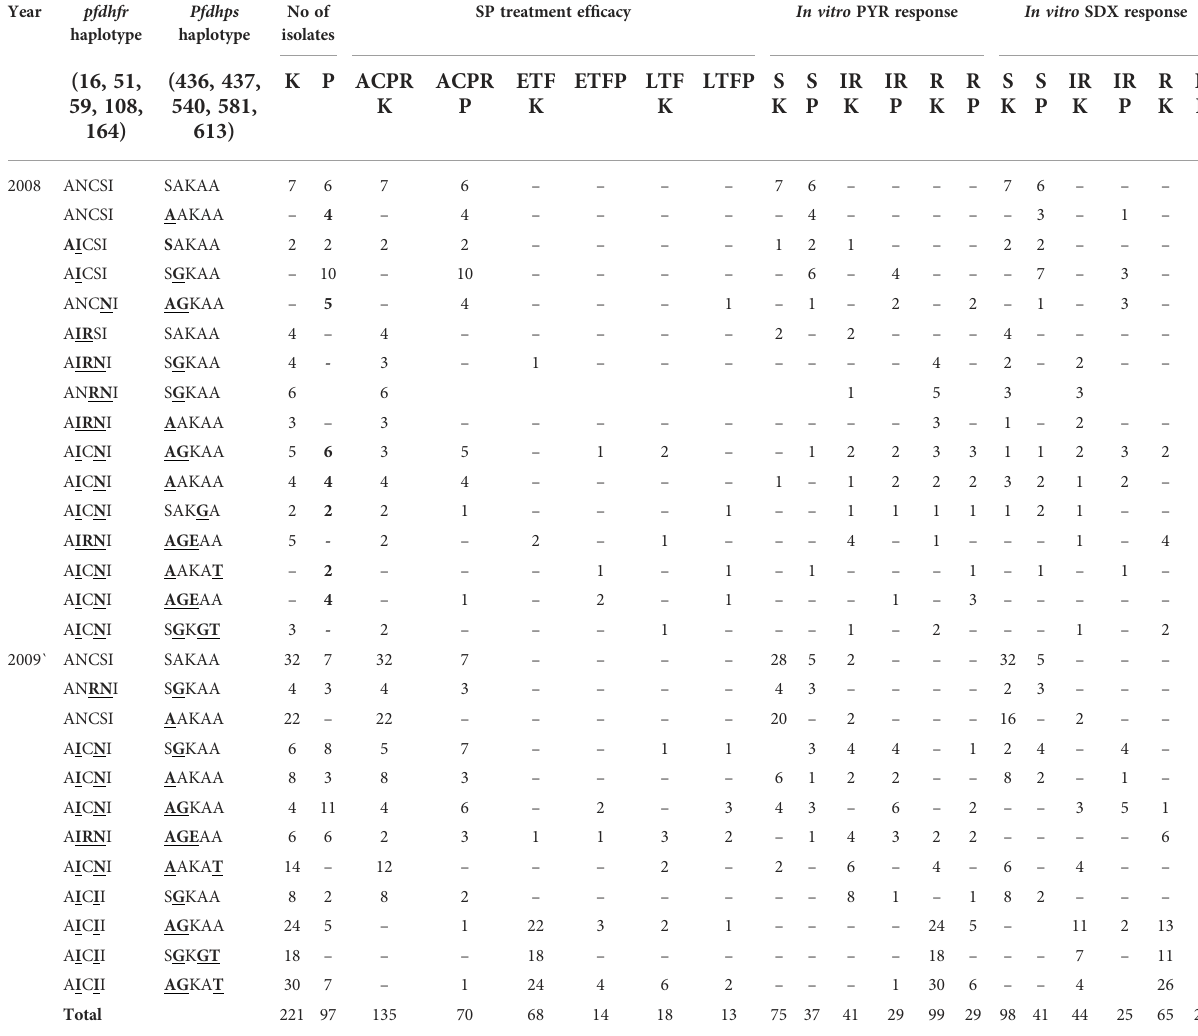
TABLE 2 Distribution of different pfdhfr and pfdhps haplotype in relation to in vivo SP ef fi cacy and in vitro SP susceptibility in Kolkata and Purulia before new national drug